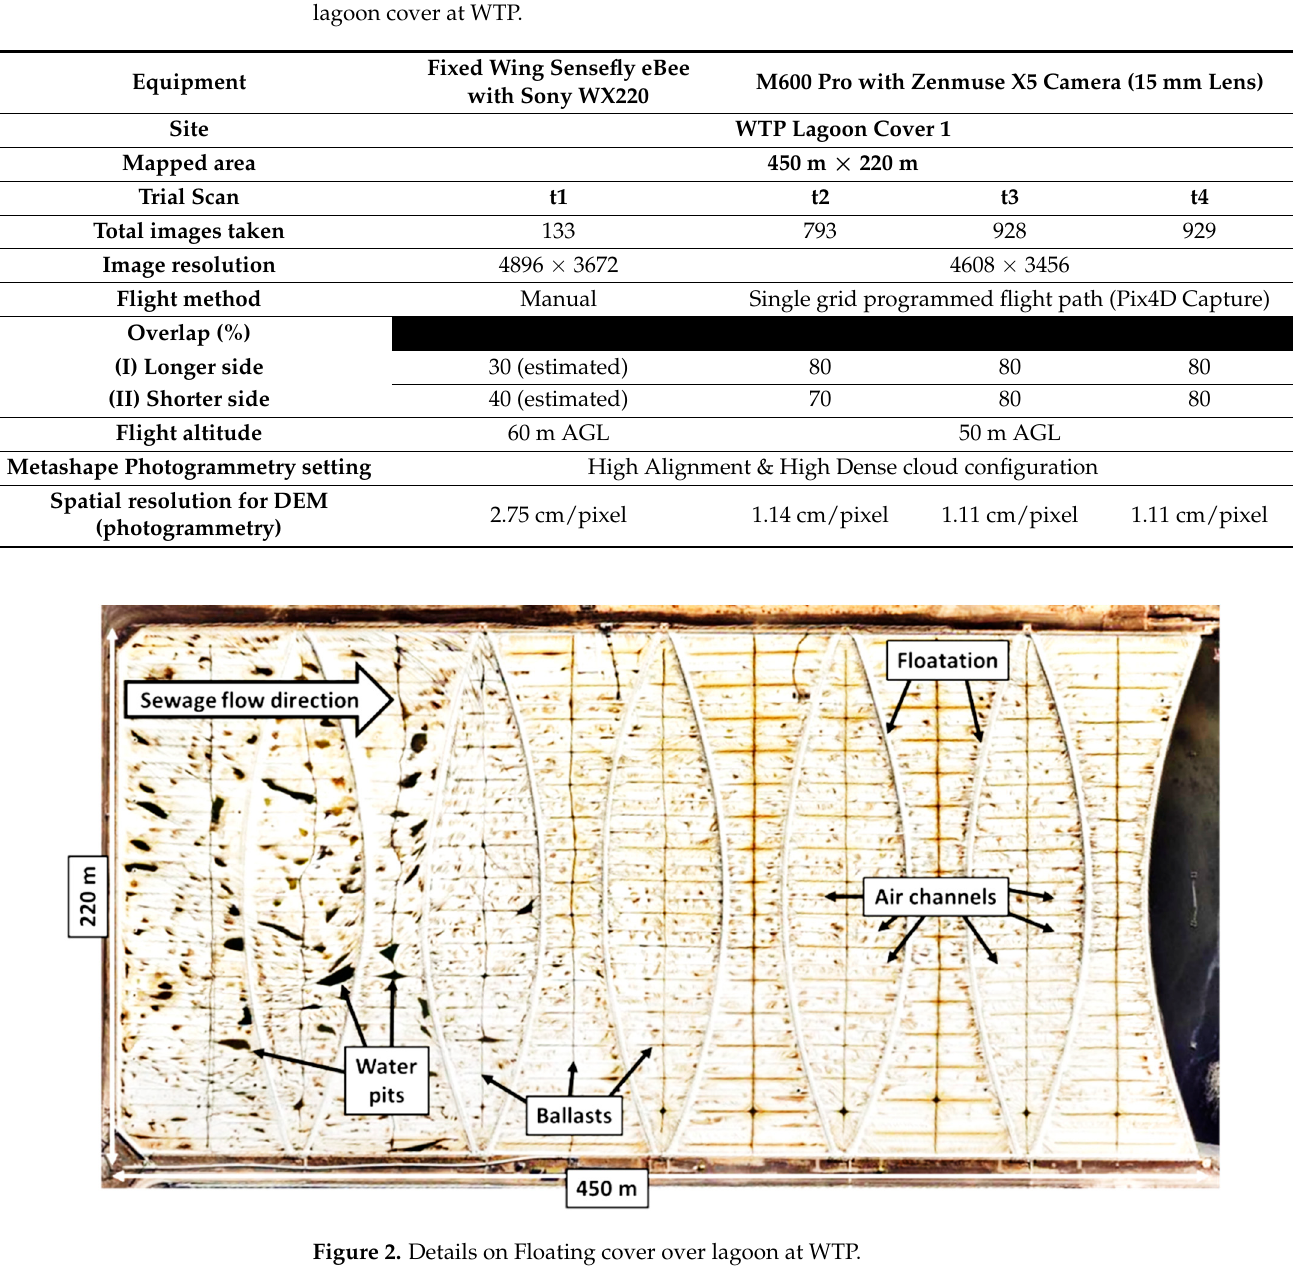
Table 1. Flight parameters and Photogrammetry configurations for the UAV surveillances over the lagoon cover at